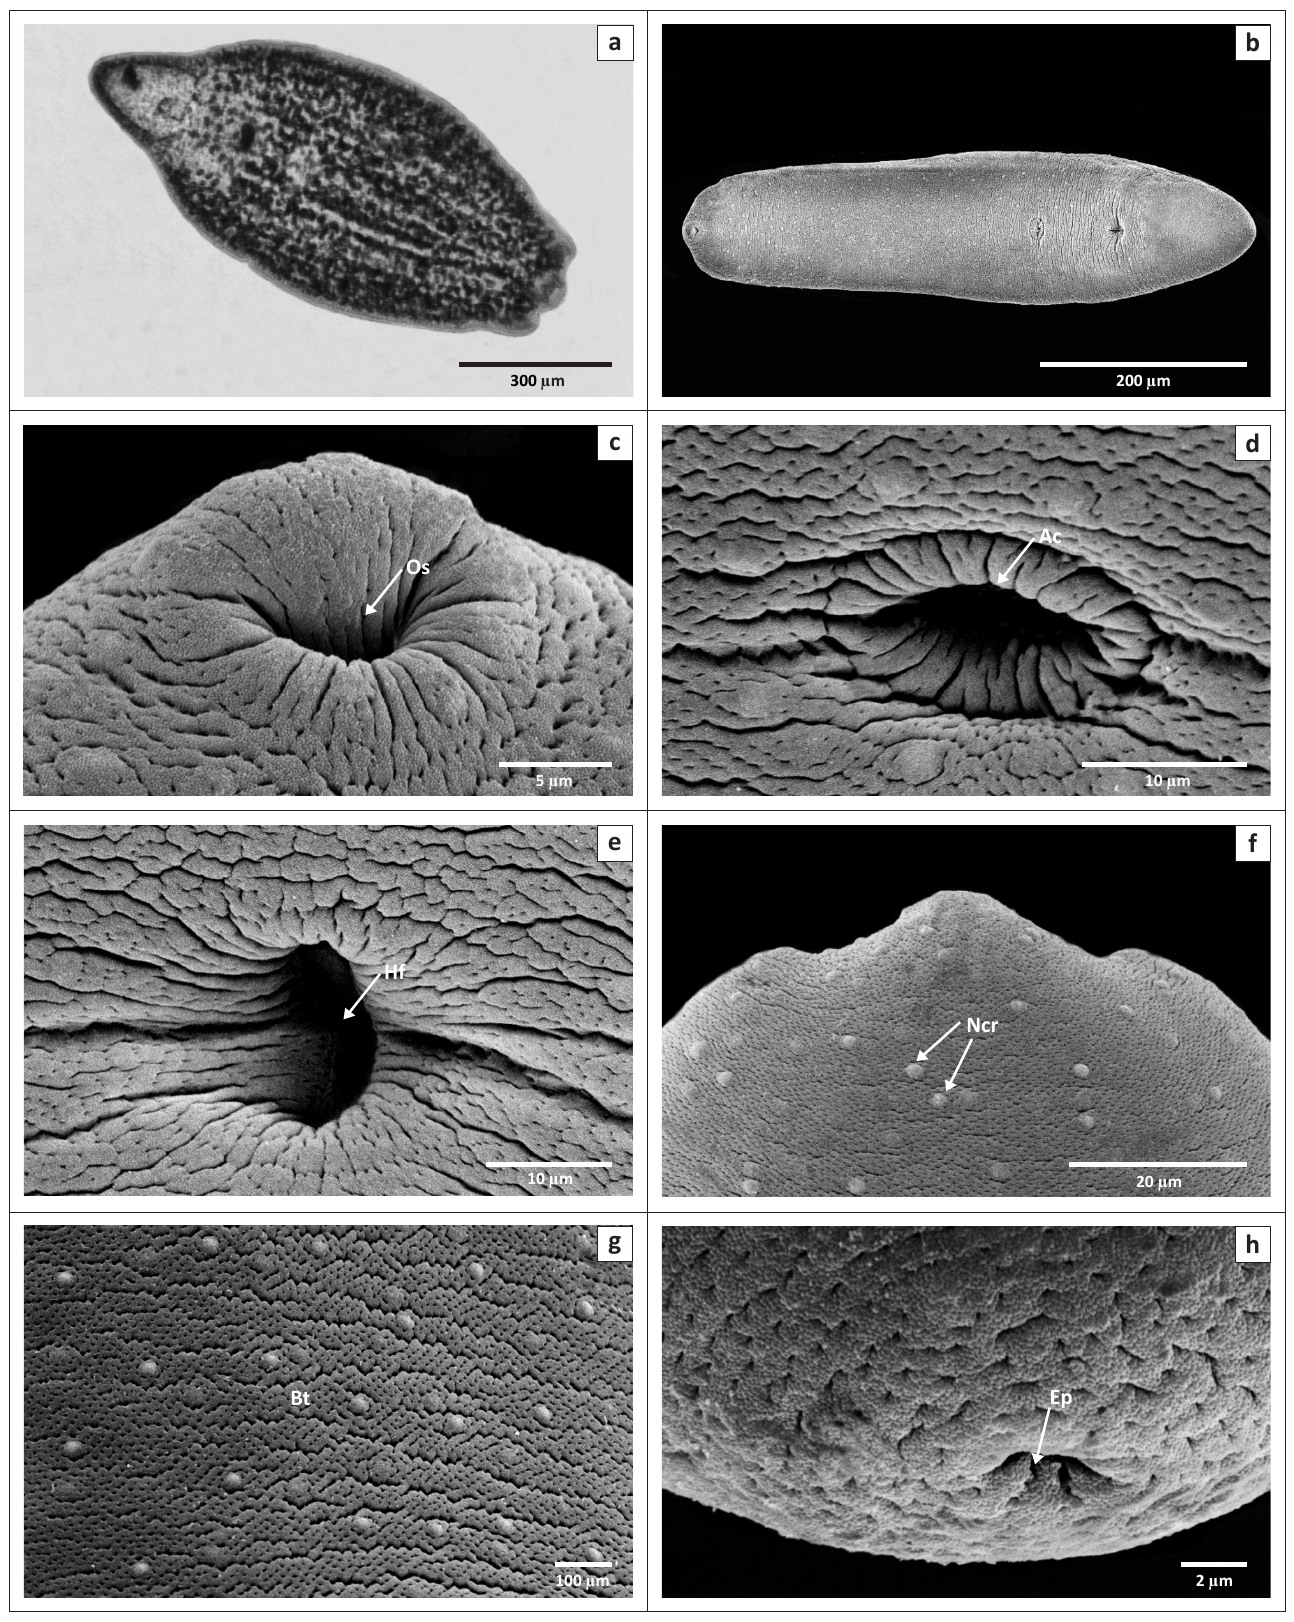
Note: Figure b–h are scanning electron micrographs of Diplostomid metacercaria B from the vitreous chamber of Tilapia sparrmanii and Pseudocrenilabrus philander collected from Supersand dam, Gauteng Province. Hosts: Tilapia sparrmanii ( T. sparrmanii ) and Pseudocrenilabrus philander ( P. philander ). Preferred site in the host: Vitreous chamber. Locality: Boekenhoutskloof farm Dam and Supersand Dam, Gauteng Province Os, Oral sucker; Ac, Acetabulum; Hf, Holdfast organ; Ncr, Non-ciliated receptors; Bt, Body tegument; Ep, Excretory pore FIGURE 3: Light and scanning electron micrographs, (a) Light micrograph, (b) Whole mount, (c) Oral sucker, (d) Acetabulum, (e) Holdfast organ, (f) Non-ciliated receptors dorso-anteriorly on the body, (g) Body tegument with many Non-ciliated receptors and (h) Excretory